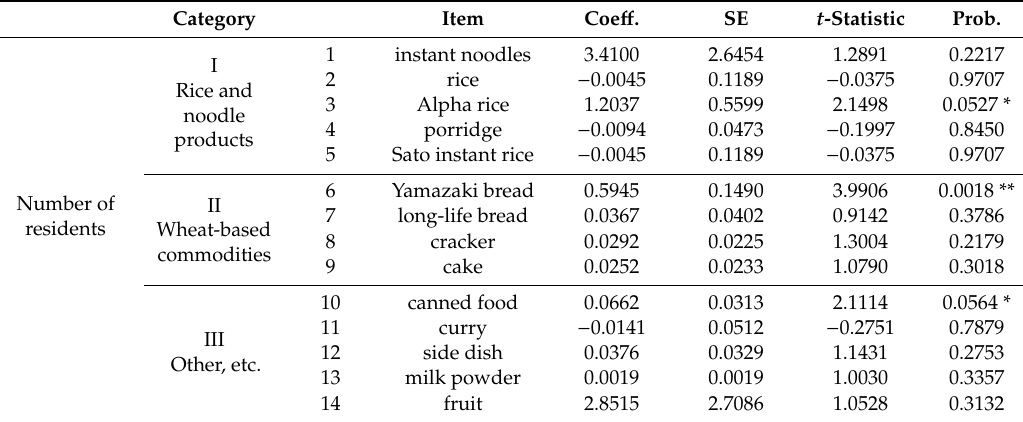
Table 3. Correlation coe ffi cient results.